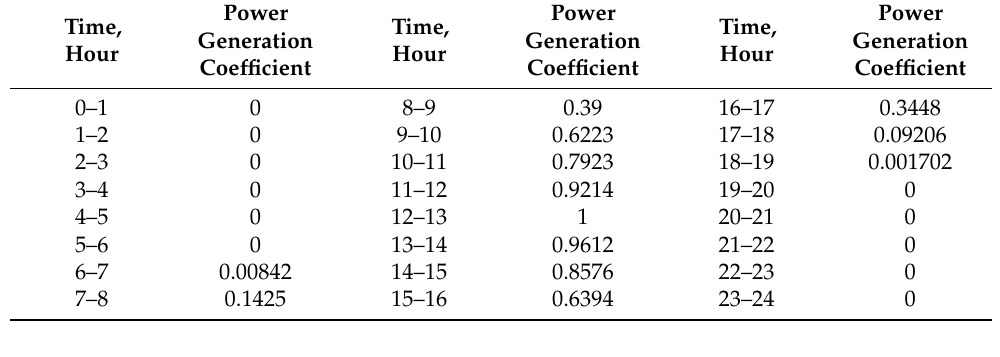
Table 1. Hourly power generation coefficient.